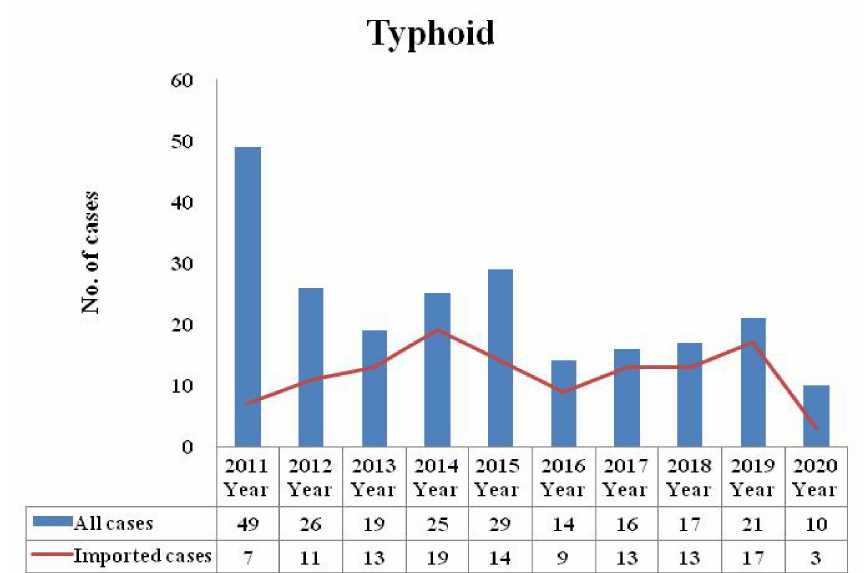
Figure 1. Number of typhoid cases reported in Taiwan from 2011 to 2020 (total (blue) and im- ported (red)). The total number of typhoid cases will increase due to the increase in the number of imported